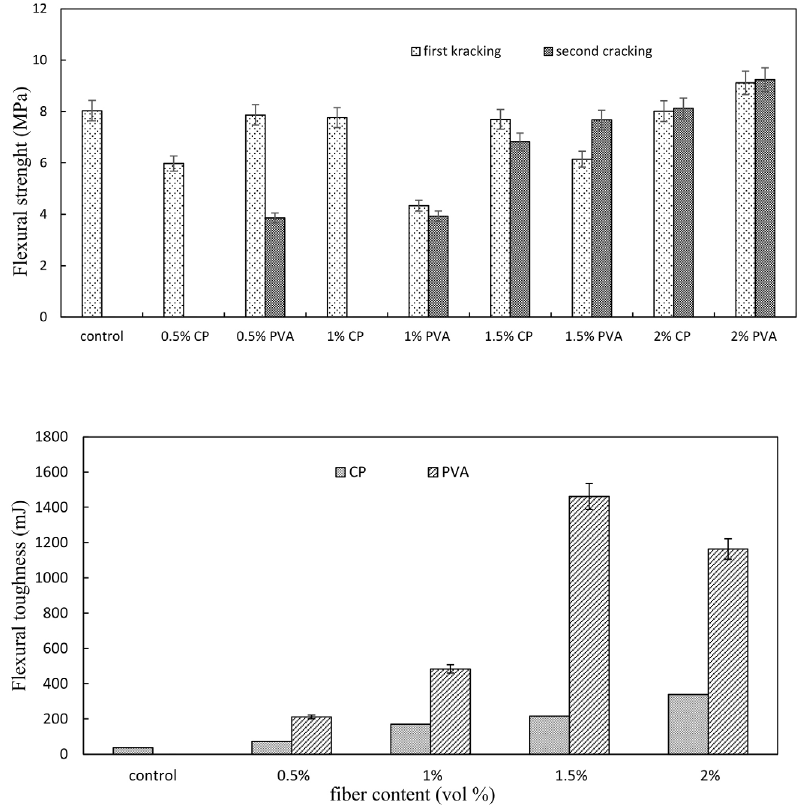
Fig. 8. Flexural properties of composites containing different content of PVA and CP